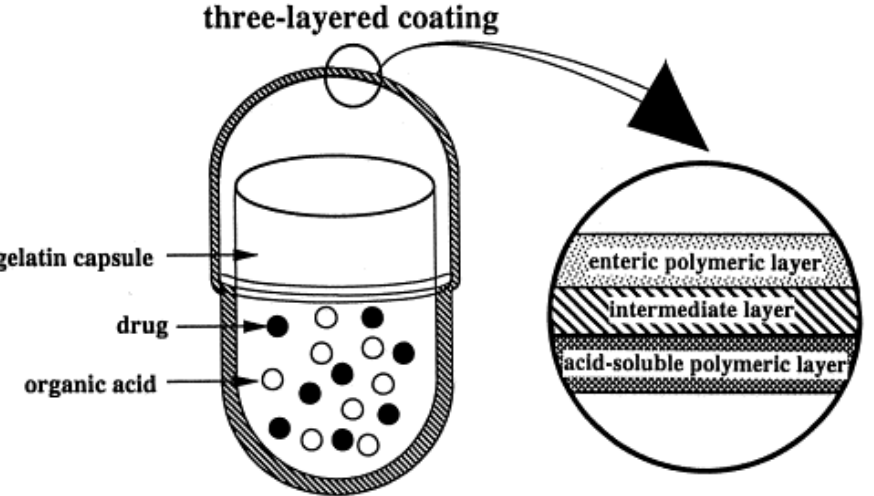
Figure 13. Schematic representation of the CTDC system. Reprinted with permission from Ref. [53]. 1998, Elsevier. Table 5. CTDC transit and disintegration times of placebo units — eight fasted volunteers. Adapted with permission from Ref. [55]. 1998, Elsevier.